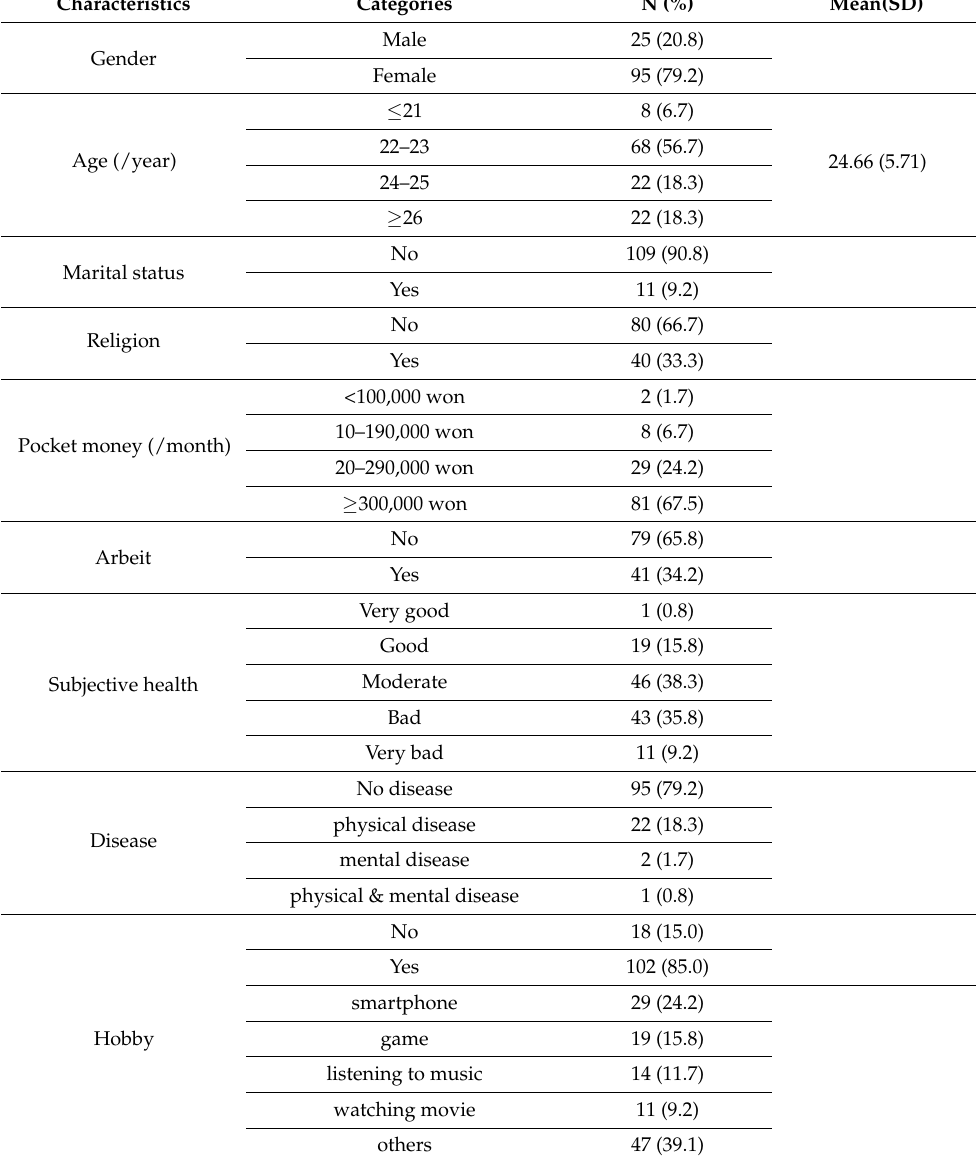
Table 1. General Characteristics of